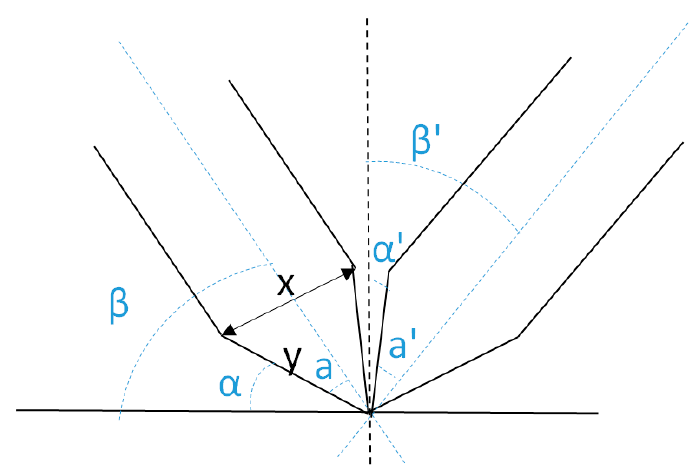
Figure 1. Schematic representation of the geometries of the two tips. The wires should be tilted at a minimum angle β from the horizontal axis to ensure that the tip end interacts with the sample. Additionally, the wires should be tilted a minimum angle β ’ from the vertical axes to ensure the tip visibility from the optical microscope.